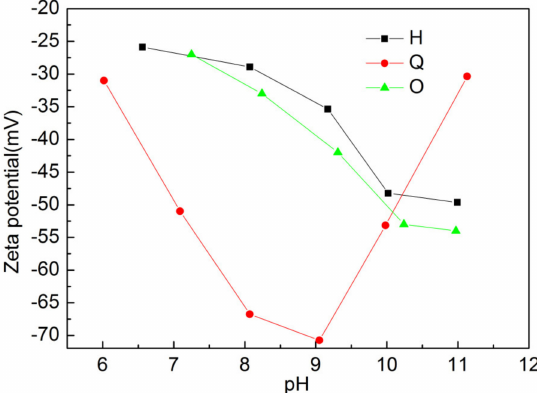
Figure 9. The ζ potential of quartz (Q), hematite (H) and orthoclase (O) as a function of pH at constant ionic strength of 1.0 mM KNO